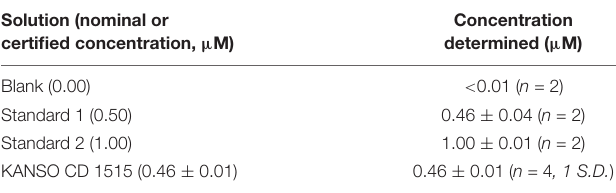
TABLE 2 | The concentration of blank and standard solutions determined by gas-segmented flow techniques upon